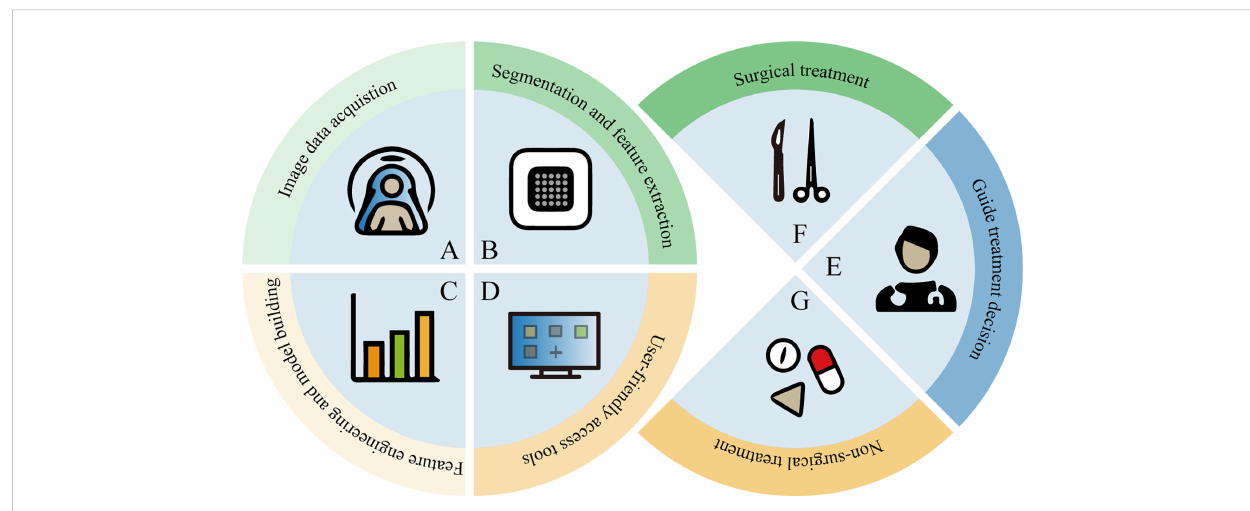
FIGURE 1 Radiomics model development and application